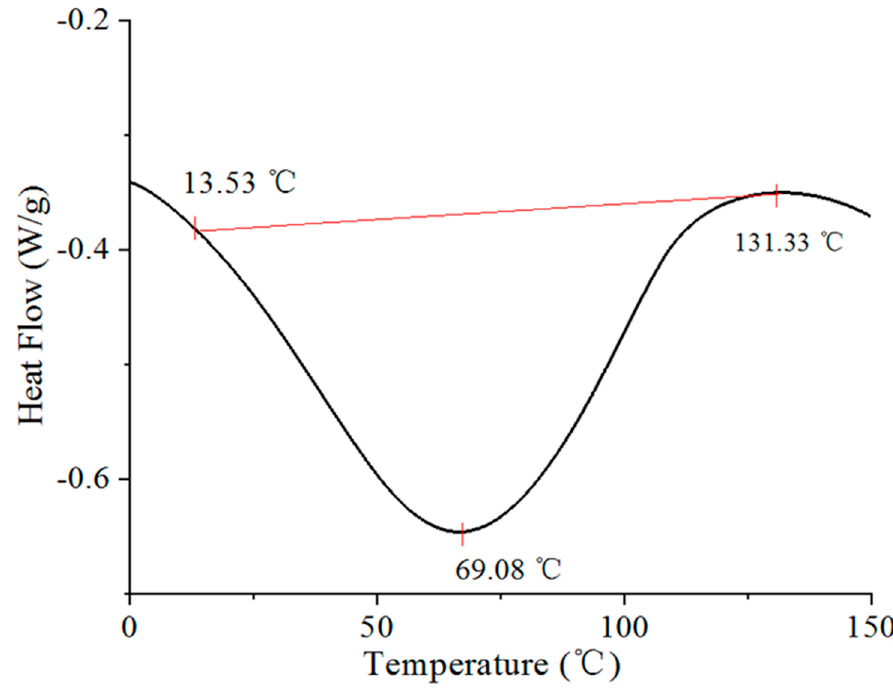
Figure 5. The differential scanning calorimetry analysis image of LK_CG_TP microspheres.